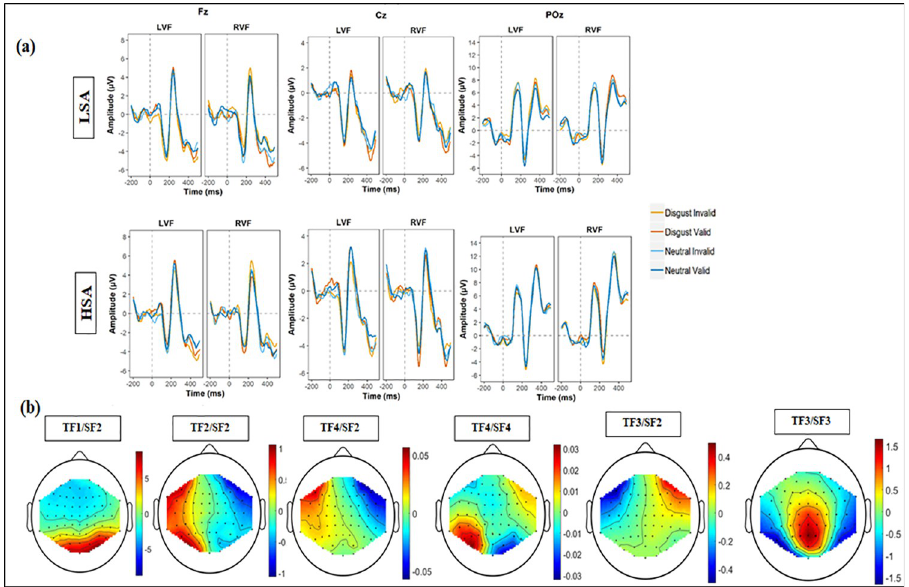
Fig 3. ERPs associated with targets processing. (a) Grand average ERPS prior to PCA analyses for the two types of faces (disgust and neutral) and the two validity conditions (valid and invalid), and the two visual fields (RVF = right visual field: LVF = left visual field) obtained at Fz, Cz, and POz; (b)Topographic maps for the temporal-spatial factors associated with targets processing.